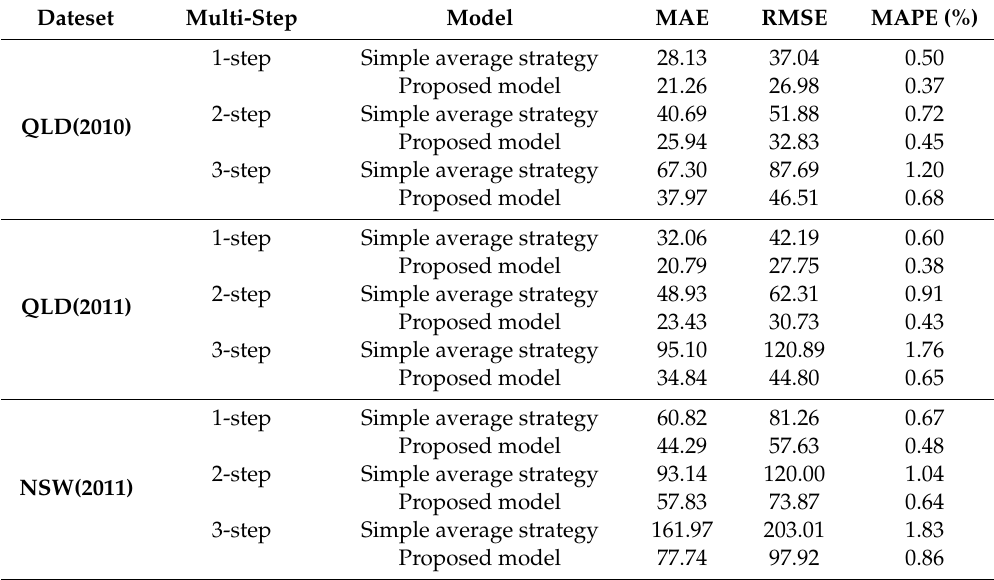
Table 11. Comparison between proposed model and simple average